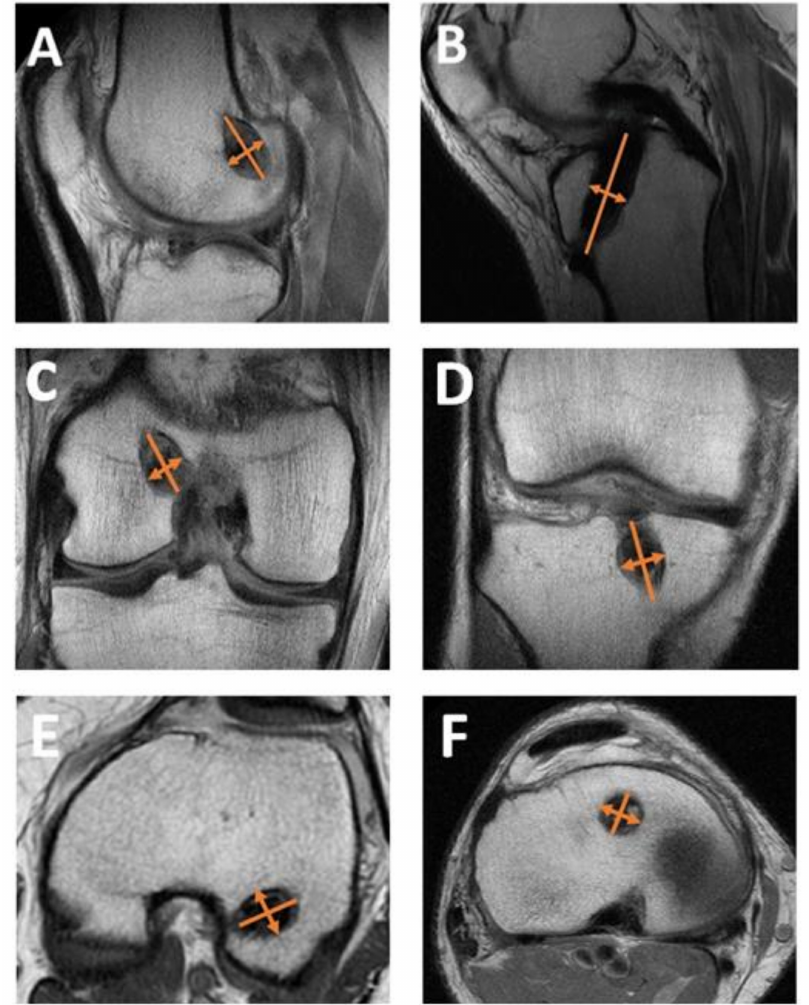
Figure 2. Measurements of tunnel expansion are shown in diagrams A-F: the femoral tunnel diameter was determined in each region of interest by taking measurements of the diameter perpendicular to the greatest diameter in the ( A ) sagittal, ( C ) coronal, and ( E ) axial MRI images; the tibial tunnel diam- eter was measured in each region of interest by taking measurements of the diameter perpendicular to the tunnel in the ( B ) sagittal, ( D ) coronal, and ( F ) axial MRI